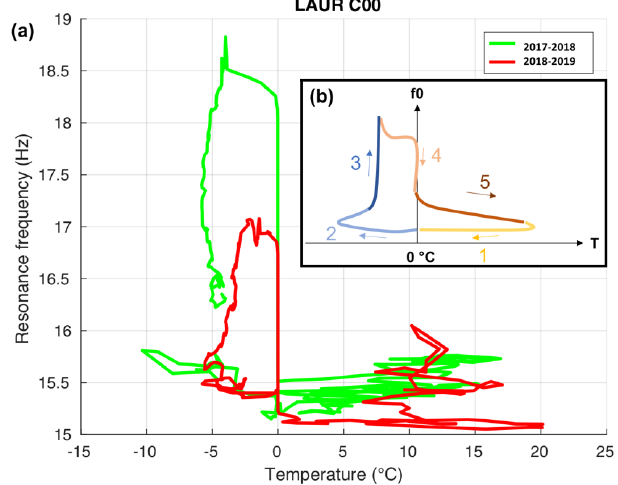
Figure 11. (a) Diagram of daily averaged ground temperature (recorded by miniature temperature data loggers) versus daily av- eraged resonance frequency of the first mode recorded by C00 seis- mometer at Laurichard rock glacier. The green line corresponds to data from December 2017 to November 2018, while the red line corresponds to data from December 2018 to October 2019.